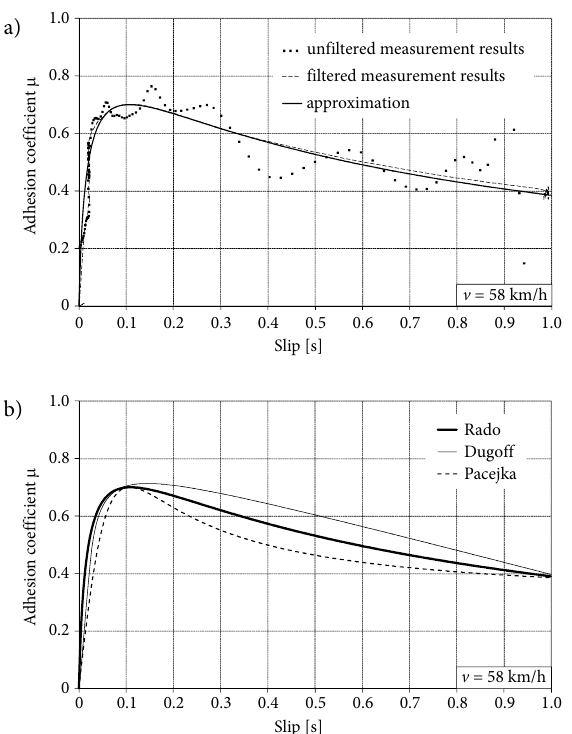
Figure 5. Exemplary m ( s ) characteristics: a – unfiltered, filtered results and one exemplary approximation; b – approximations